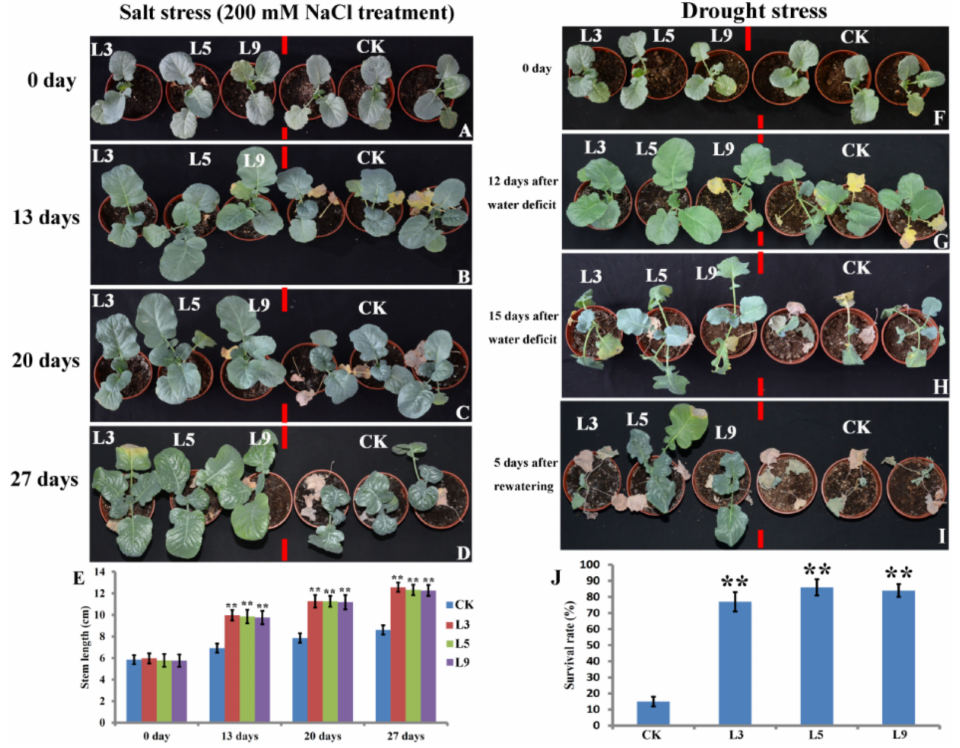
Figure 4. Phenotypes of transgenic broccoli plants overexpressing bolTLP1 under salt and drought stresses. ( A – D ): Phenotypes of 35S:: bolTLP1 broccoli at 0 day, 13 days, 20 days and 27 days after irrigated with 200 mM NaCl, respectively. ( E ): Stem length of 35S:: bolTLP1 broccoli at 0 day, 13